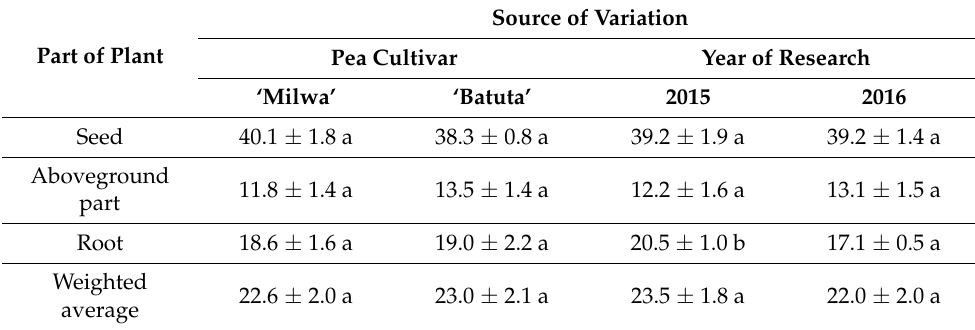
Table 6. Nitrogen content in dry weight of pea at BBCH stage 90, g N · kg − 1 (means for cultivars, and for years of research from three replications ± SD).